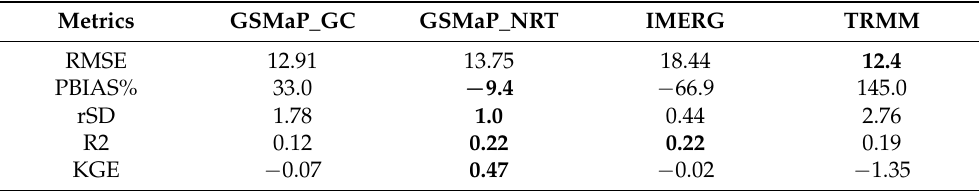
Table 4. Performance of different satellite rainfall data in replicating observed daily rainfall in Yangon International